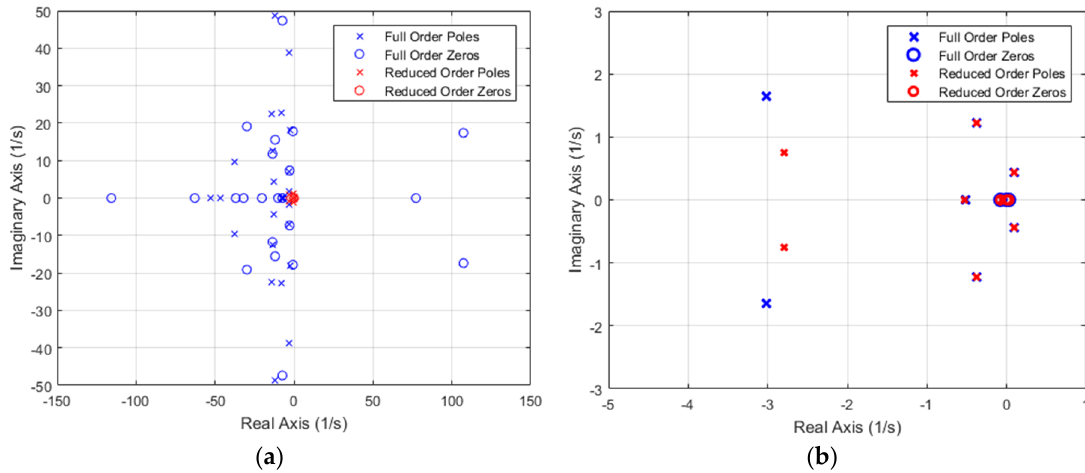
Figure 7. Pole-zero map of full and reduced order dynamic models at 80 kts. ( a ) The full-order model exhibits three very high frequency non-minimum phase (NMP) zeros. The reduced order model poles and zeros are all clustered at low frequency, corresponding to the rigid body modes. ( b ) Close up at low frequency focuses on the rigid body modes and nearby zeros. Note that the reduced order model poles and zeros nearly overlay corresponding full order model poles and zeros, with the exception of the poles with real parts around − 3, where there is some discrepancy in damping. The full and reduced order both have one very low frequency zero in the right half plane. As will be shown, this non-minimum phase zero will cause the controlled system to have a very slow divergent mode when using a dynamic inversion (DI) design with the reduced order model. This can be fixed through a small change in controlled variable (CV). The high frequency zeros of the full order system would be much more problematic, if one attempted to design DI with this high order model. Table 2. Summary of eigenvalues at 80 kts forward flight, full and reduced order models. Mode Full Order Eigenvalues Reduced Order Eigenvalues